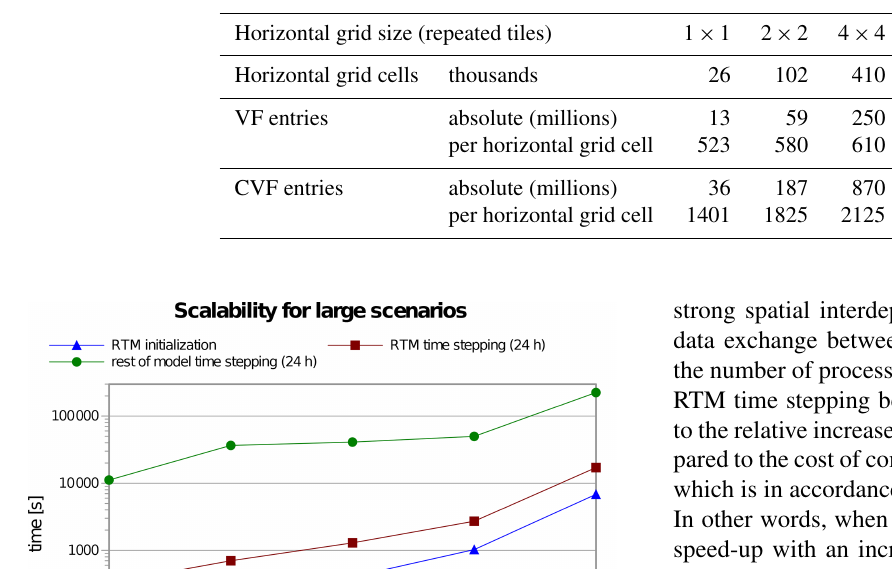
Table 2. Scaling of the number of view factor entries.